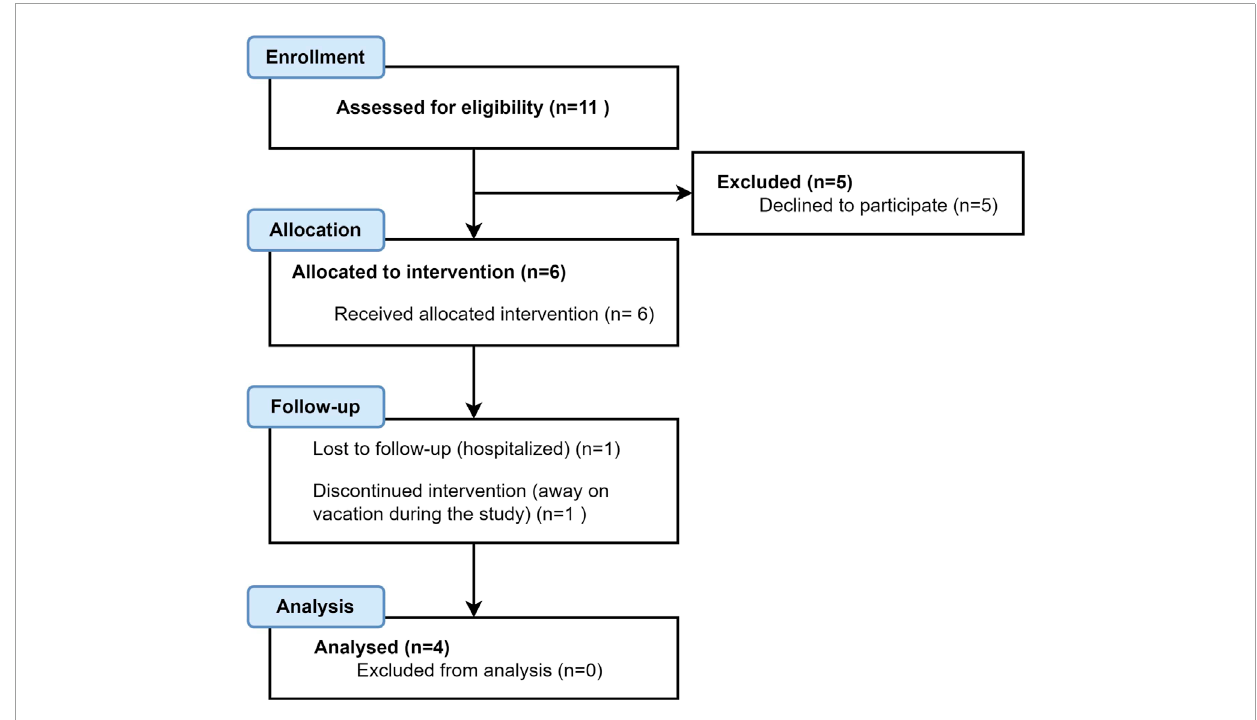
FIGURE 1 CONSORT (Consolidated Standards of Reporting Trials) flow